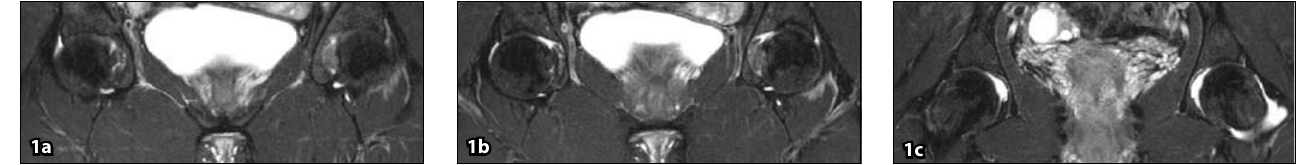
Fig. 1 Unenhanced coronal fat-suppressed proton density MRI sequences. Figs 1a - c from anterior to posterior.